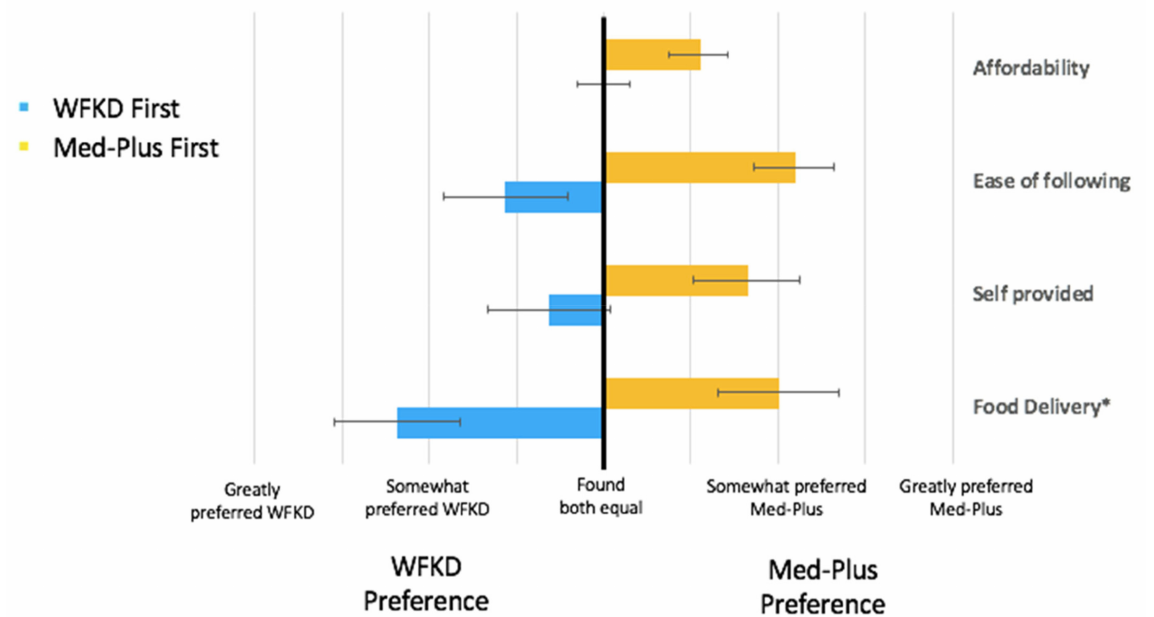
Figure 4. Mean and standard deviation of food satisfaction between Med-Plus and WFKD depending on what diet participants were assigned first. * For the food delivery, n = 6 receiving WFKD as the second phase and n = 7 receiving Med-Plus as the second phase did not receive food delivery due to COVID-19 disruption, as previously described.